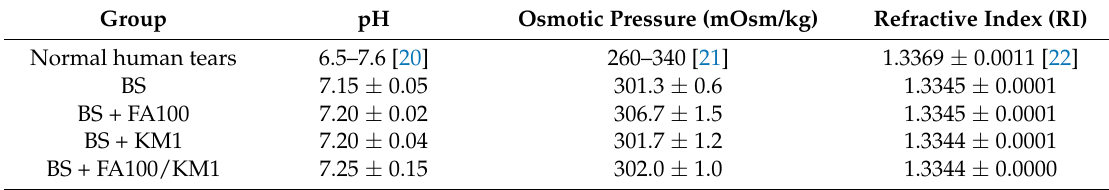
Table 1. Characteristics of buffer solution (BS) with varying herbal combinations. Group pH Osmotic Pressure (mOsm/kg) Refractive Index (RI) Normal human